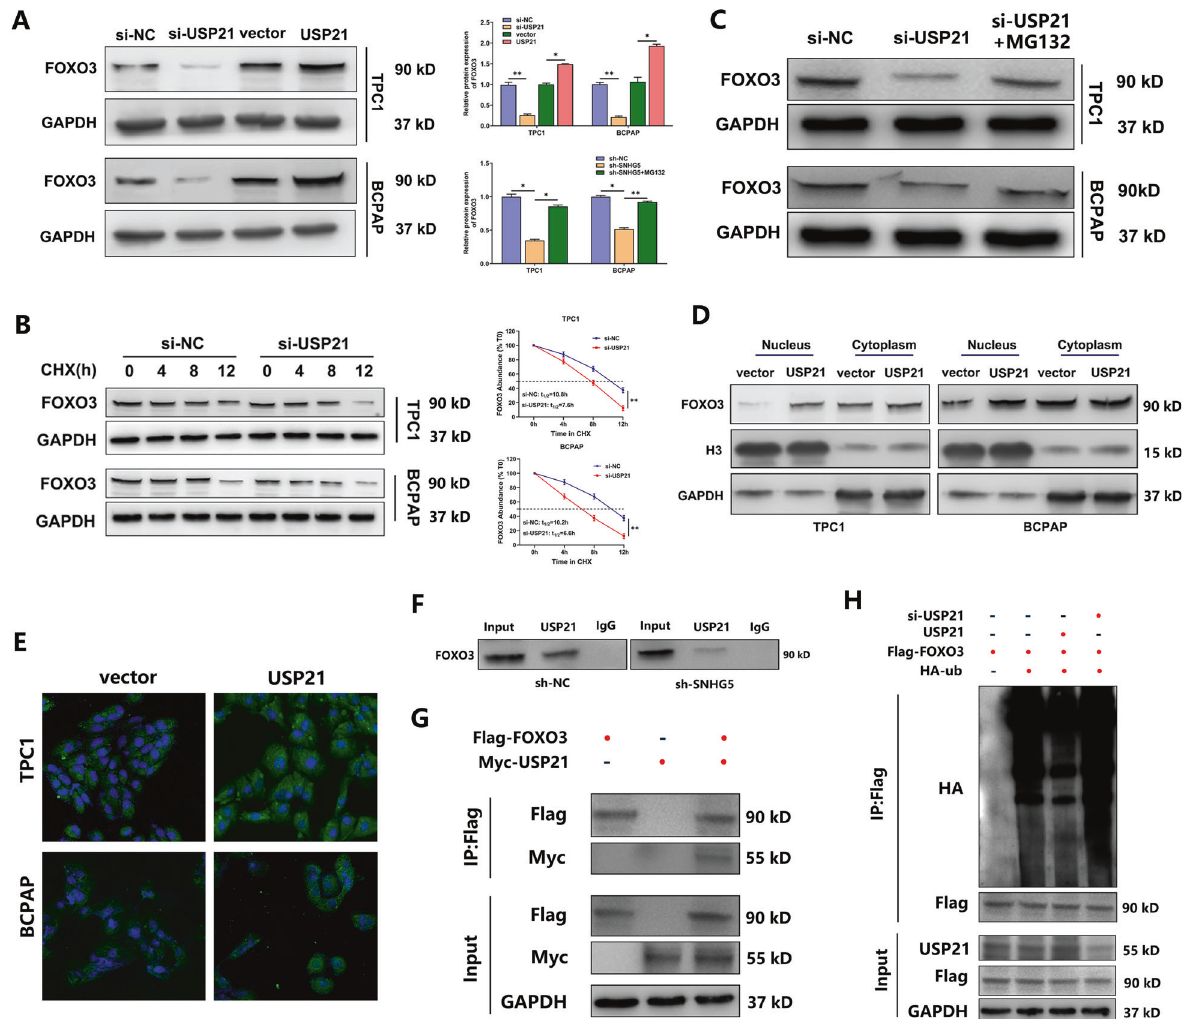
Fig. 7 USP21 inhibits FOXO3 ubiquitination and promotes its nuclear translocation. A The protein level of FOXO3 in PTC cells with USP21 knockdown or upregulation. B PTC cells were transfected with si-USP21 or si-NC for 48 h, then treated with 100 ng/mL CHX. Samples were taken every 4 h for 12 h. C PTC cells were transfected with si-USP21 for 48 h, then treated with 10 mM MG132 for 12 h. D The cytoplasmic and nuclear levels of FOXO3 in PTC cells transfected with vector and pcDNA3.1/USP21. E The effect of USP21 on FOXO3 translocation